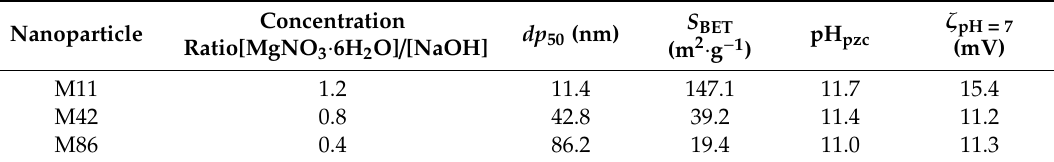
Table 1. Estimated mean particle size by DLS ( dp 50 ), estimated surface area (SBET), point of zero charge (pH pzc ), and zeta potential at pH = 7 ( ζ pH = 7 ) of the three synthesized MgO nanoparticles at 25 °C.